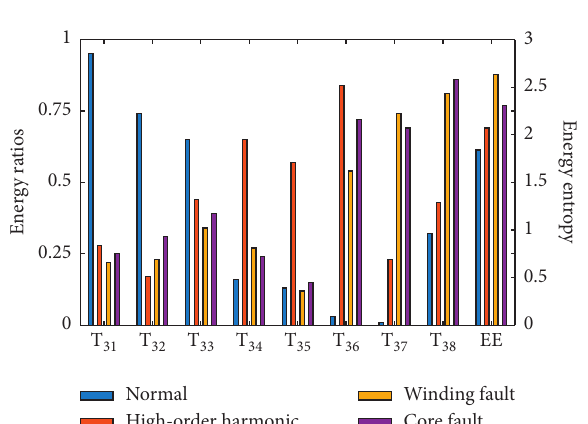
Figure 13: Energy ratios of empirical wavelet packets for four